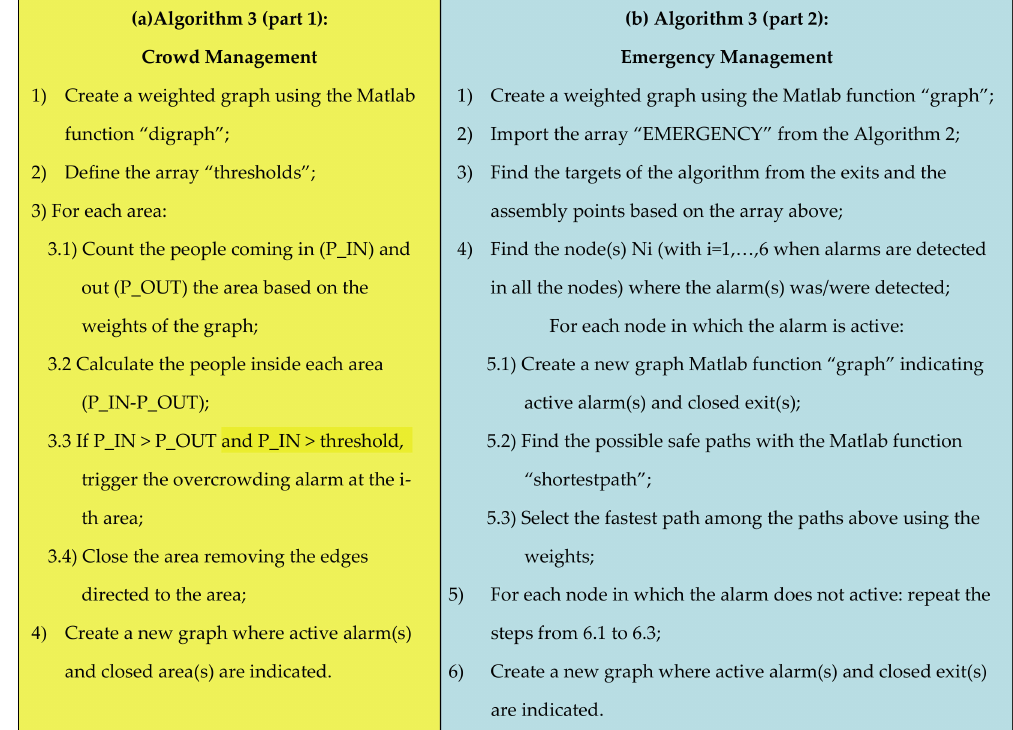
Figure 10. Pseudo-code of the Algorithm 3 for: ( a ) crowd and ( b ) emergency